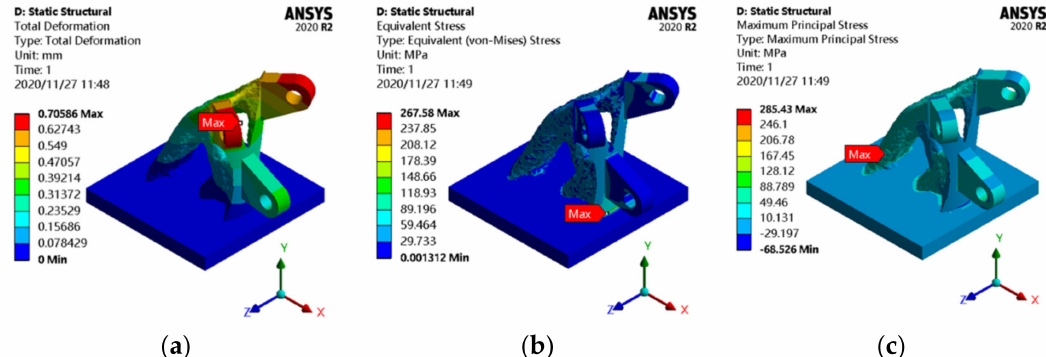
Figure 10. Static analysis results of the topology-optimized joint: ( a ) displacement cloud map; ( b ) equivalent stress cloud map; ( c ) principal stress cloud map.